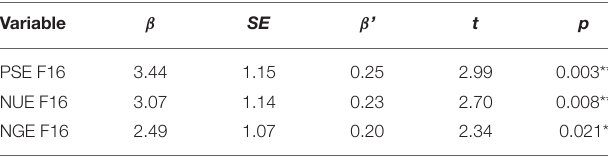
TABLE 4 | Multiple linear regression analysis of facial muscle activity intensity related to negative symptoms of